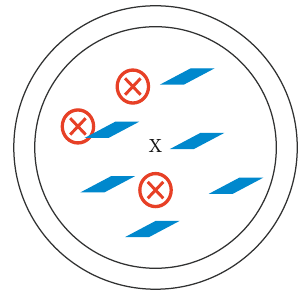
Figure 1: Two-classification